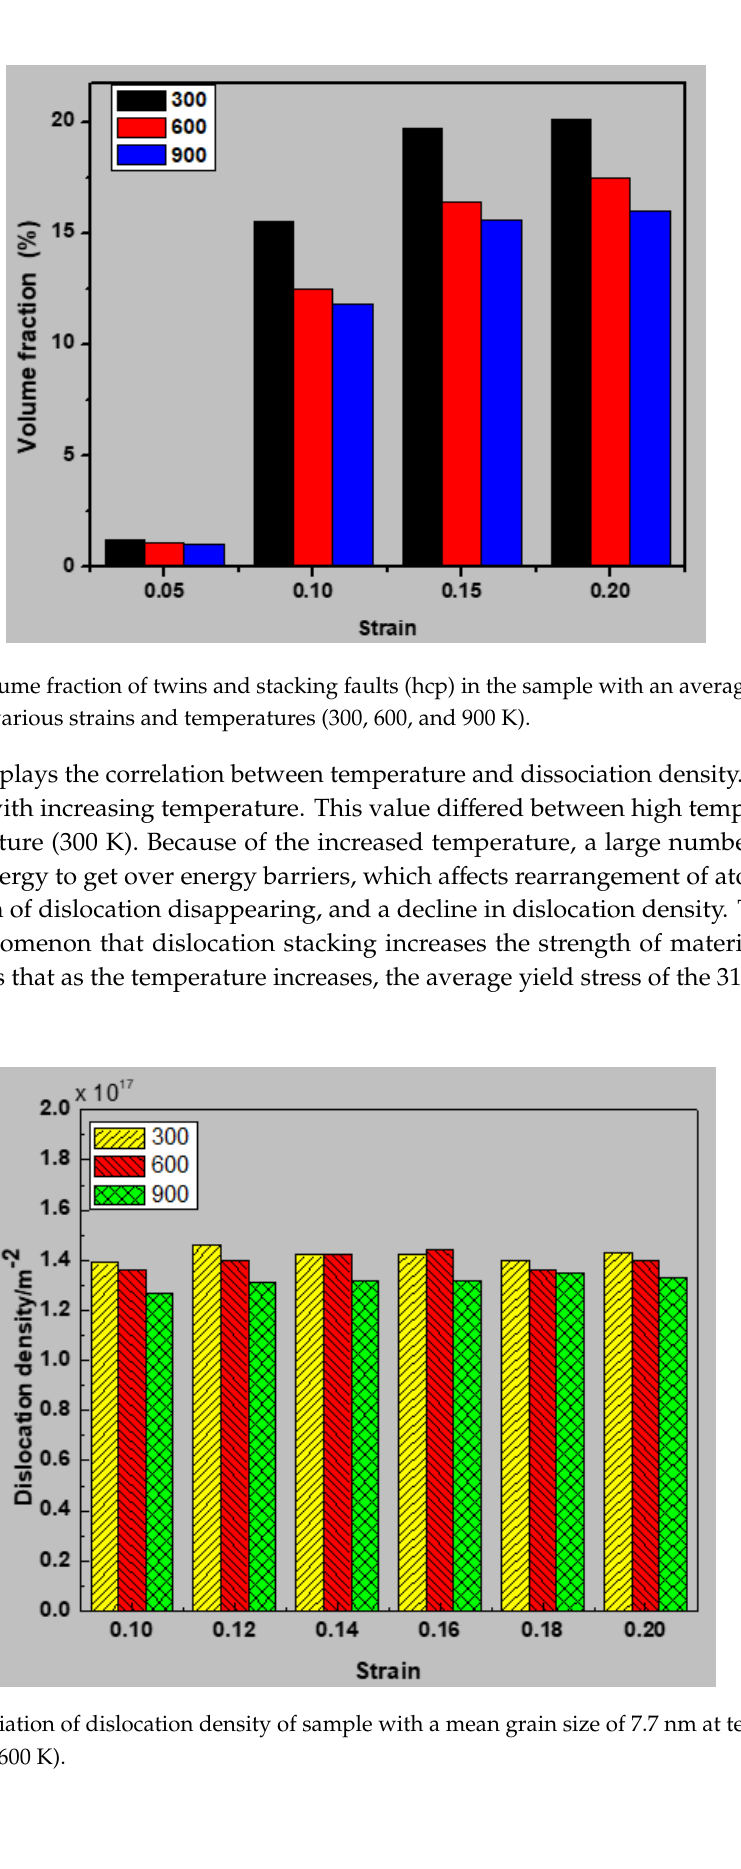
Figure 17. Variation of dislocation density of sample with a mean grain size of 7.7 nm at temperatures (300, 600, and 600 K).